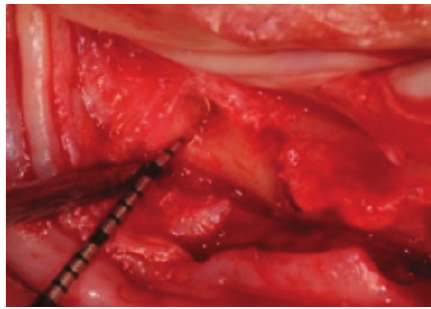
Figure 7: The distal osteotome intimate to the alveolar nerve.